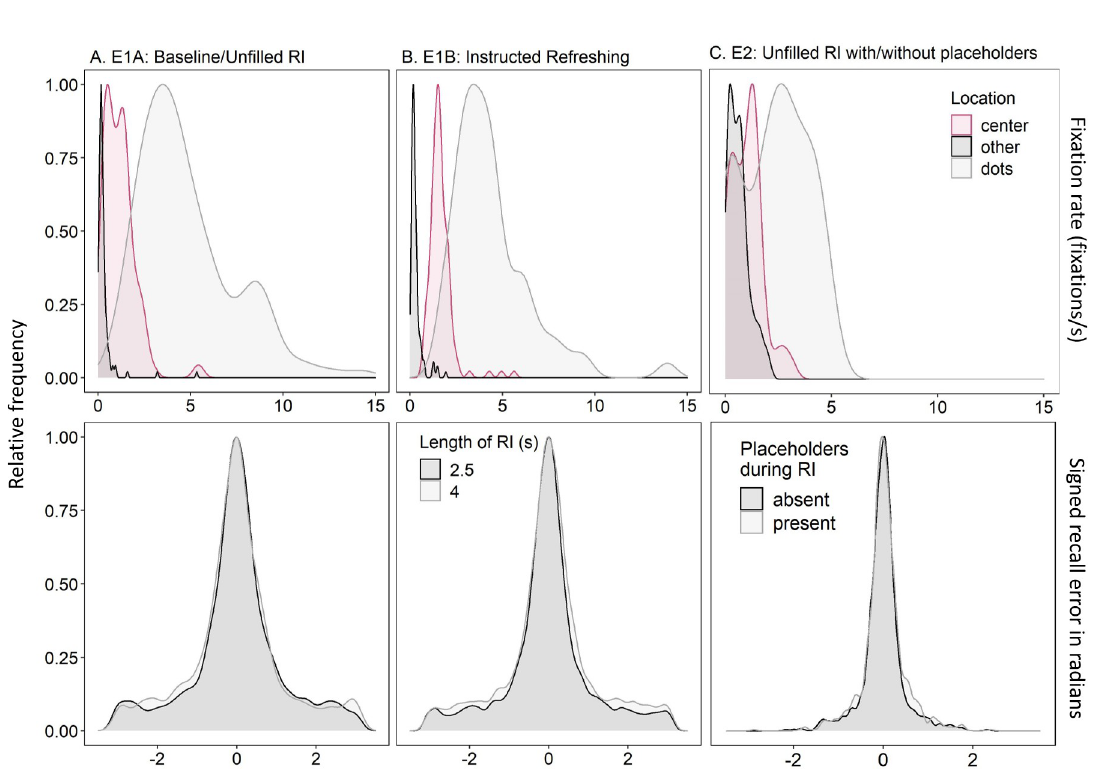
Fig 2. Density Plots of Fixation Rate (Fixations Per Second; Top Panels) and Recall Error (Transformed into Radians; Bottom Panels) in Experiments 1A (Panel A), 1B (Panel B), and 2 (Panel